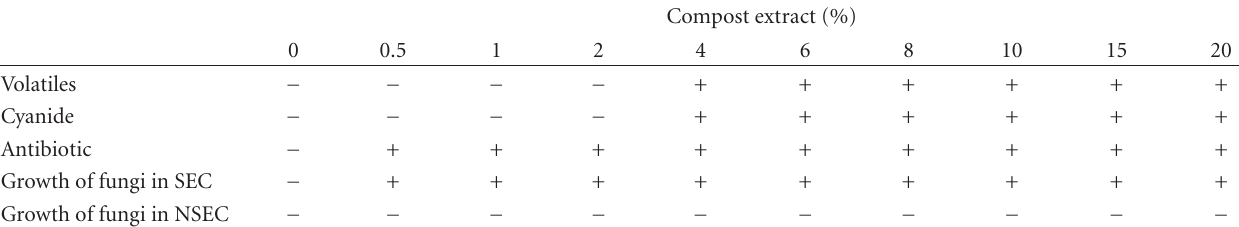
Table 1: E ff ect of doses compost in volatiles, antibiotic, cyanide production, and growth of fungi in sterilized extract compost and non sterilized compost.